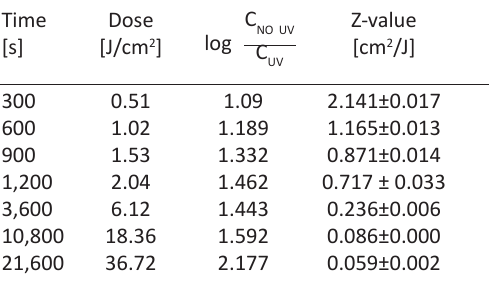
Table 1. Estimated Z-values for S. liquefaciens , determined at different times at a 15-cm distance of exposure Time Dose